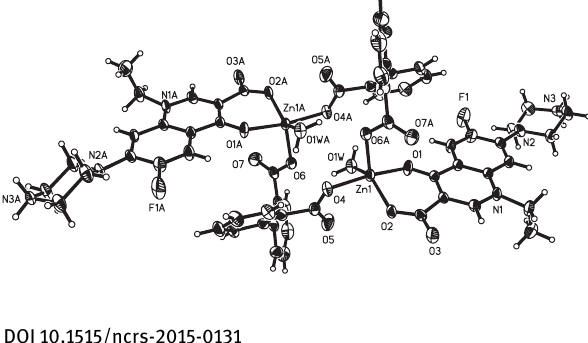
Table 1: Data collection and handling.